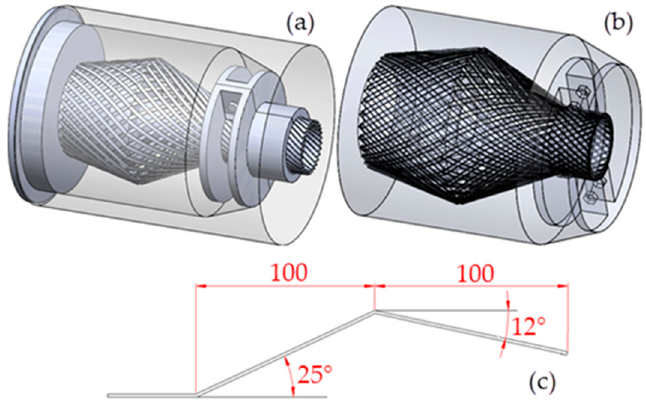
Figure 2. Geometric models used in pouring simulation: ( a ) end fitting model; ( b ) resin cavity model; ( c ) steel wire bending